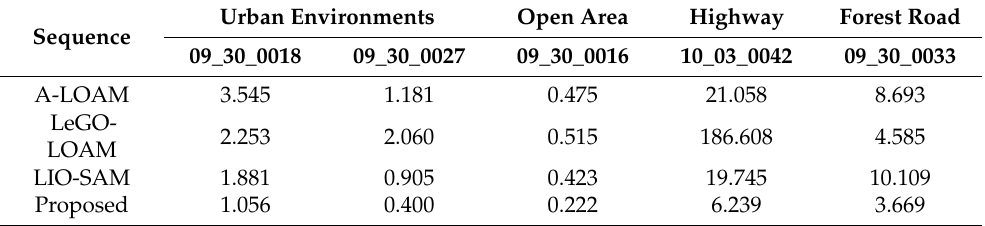
Figure 11. Comparison of the positioning error of each algorithm. ( a ) APE fitting curve. ( b ) The box diagram of APE.